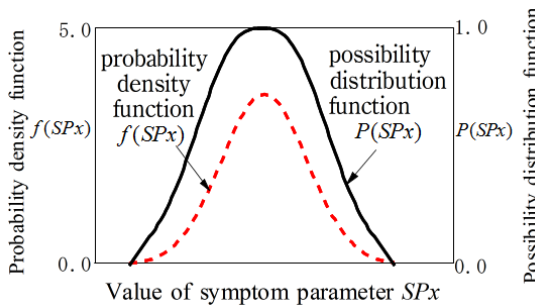
Figure 3. An example of probability possibility function and density function.